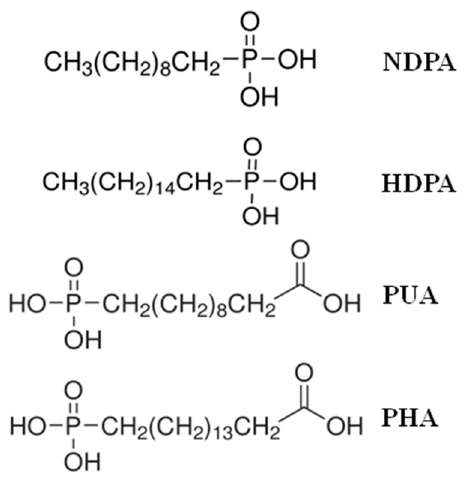
Figure 1. Chemical structures of the four kinds of self-assembled phosphonic acid solutions.